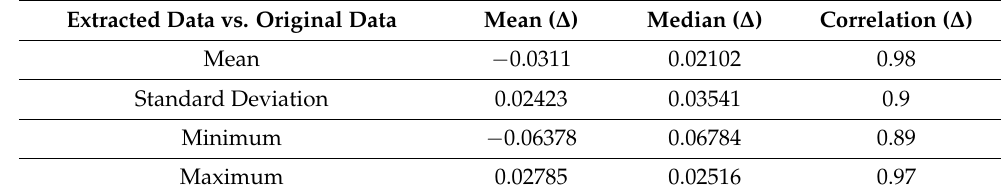
Table 3. Study of the correlation of 100 randomly selected samples.